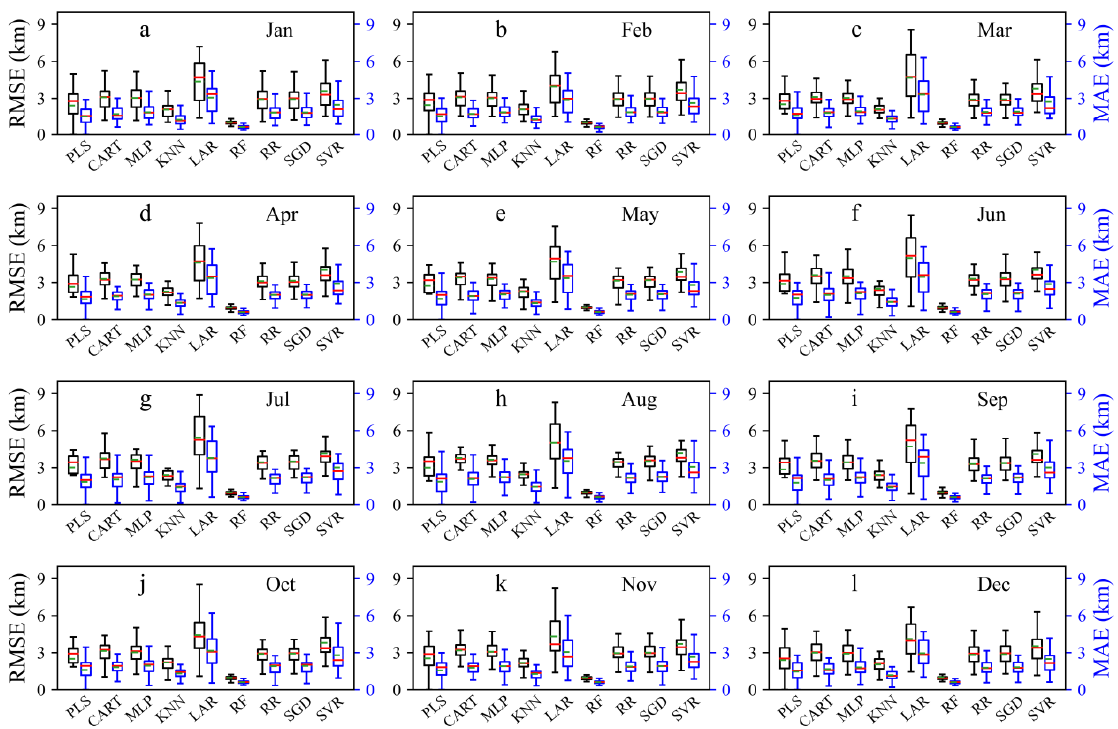
Figure 8. Root mean square error (RMSE) (black box) and mean absolute error (MAE) (blue box) between hourly visibility observations and estimates at 47 airports in the training period (2018–2019). The red solid line and green dotted line represent the median and mean of each algorithm model at 47 airports, respectively. The 25th and 75th percentiles are the bottom and top boundaries of a box, minimum and maximum are the bottom and top whiskers of a box. The notation applies for following box figures.